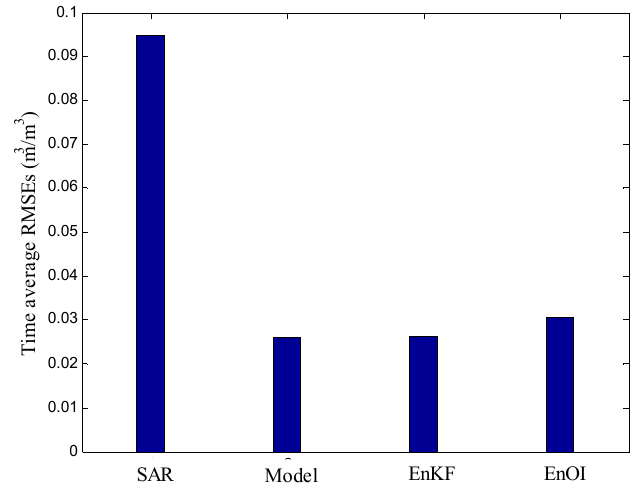
Figure 5. Time-average RMSEs of surface soil moisture (m 3 /m 3 ).